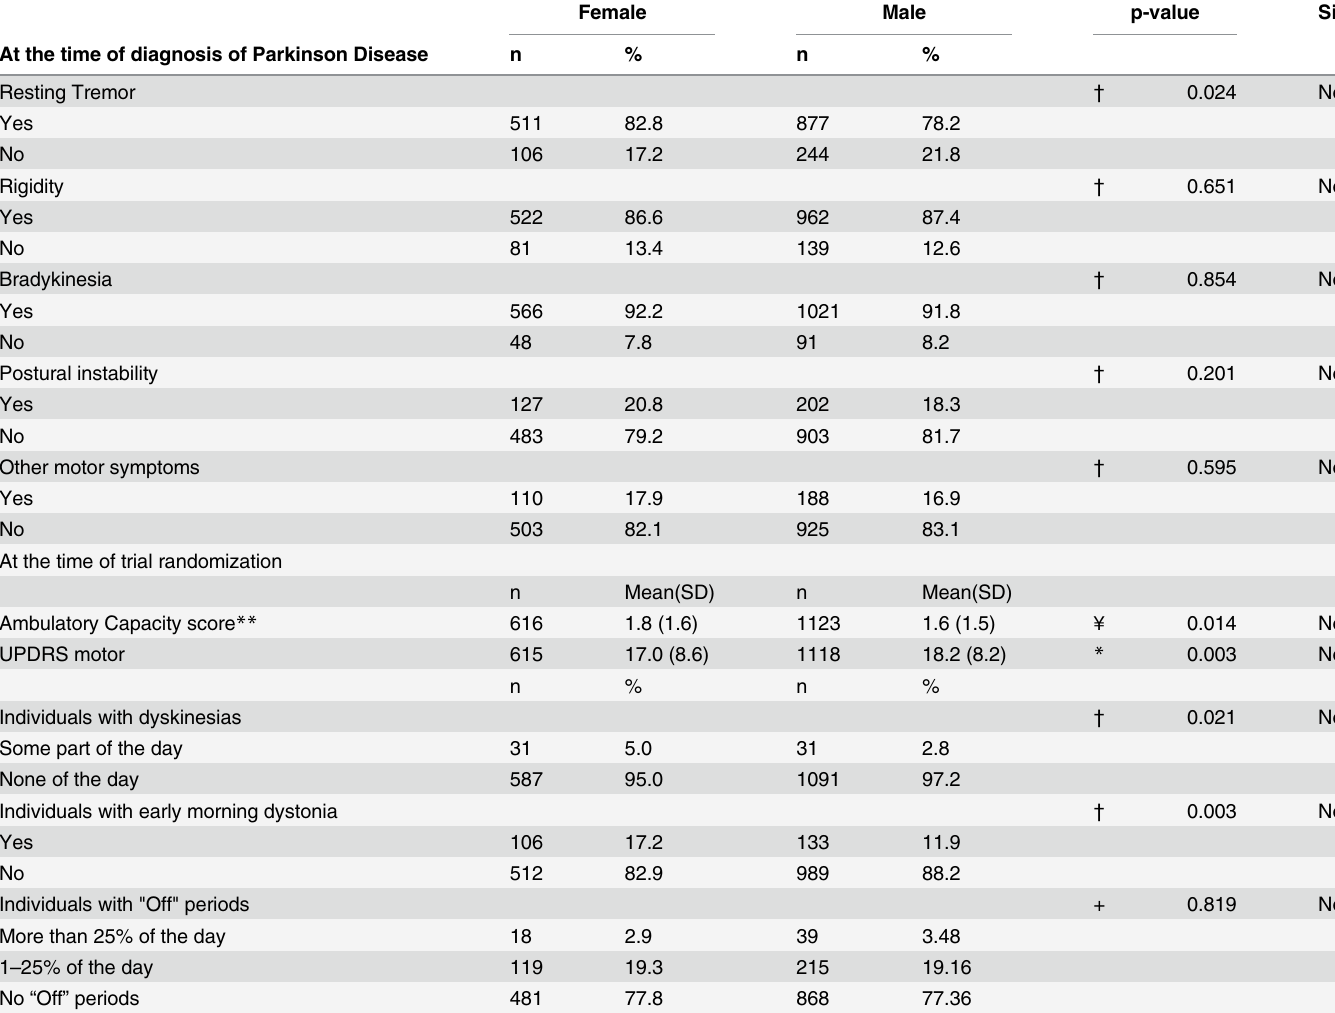
Table 2. Motor symptoms ‡